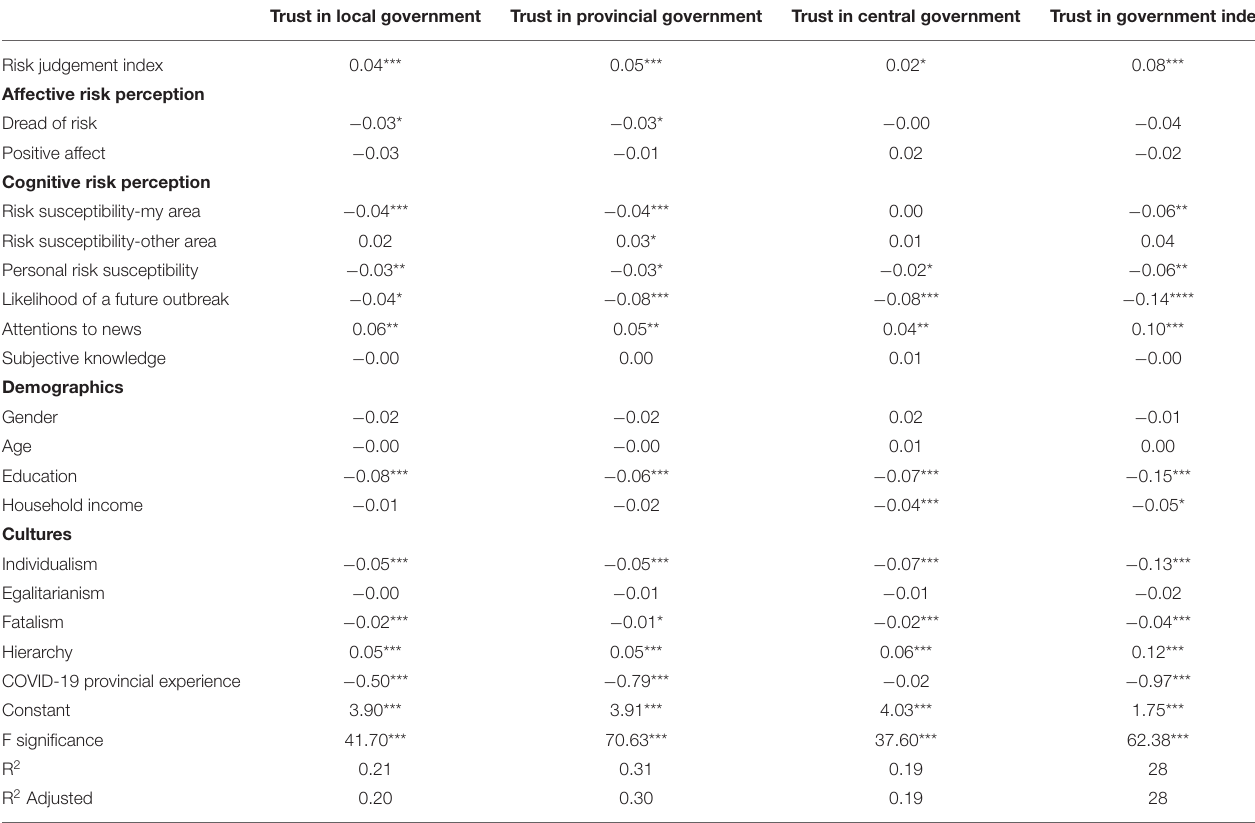
TABLE 5 | Linear regressions of trust in government and survey of public reactions to COVID-19, China, 2020. Trust in local government Trust in provincial